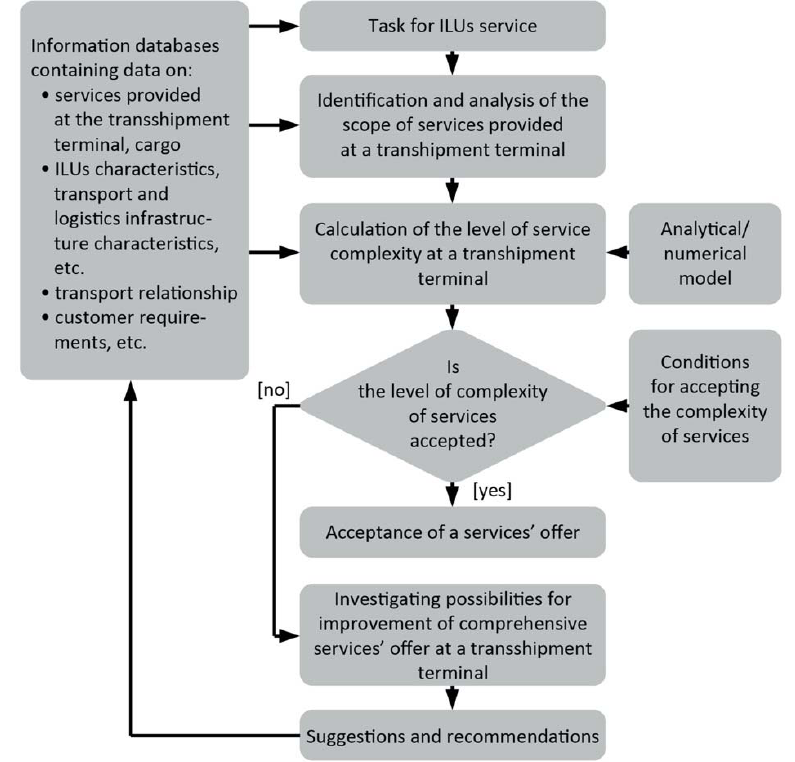
Figure 5. The procedure of assessing the complexity of ILU services at a transshipment